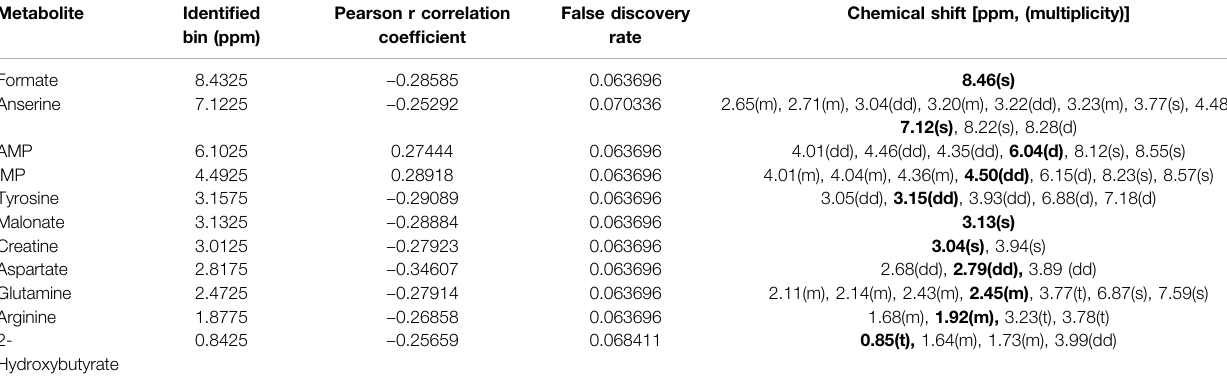
TABLE 1 | Metabolites that correlate with increasing naphthenic acid concentrations identi fi ed from the PatternHunter analysis of the polar metabolome of the may fl y, Hexagenia spp. Chemical shift and multiplicities are reported from Fan (1996) and Chenomx NMR Suite 8.3. Metabolite Identi fi ed Pearson r correlation False discovery Chemical shift [ppm, bin (ppm) coef fi cient rate